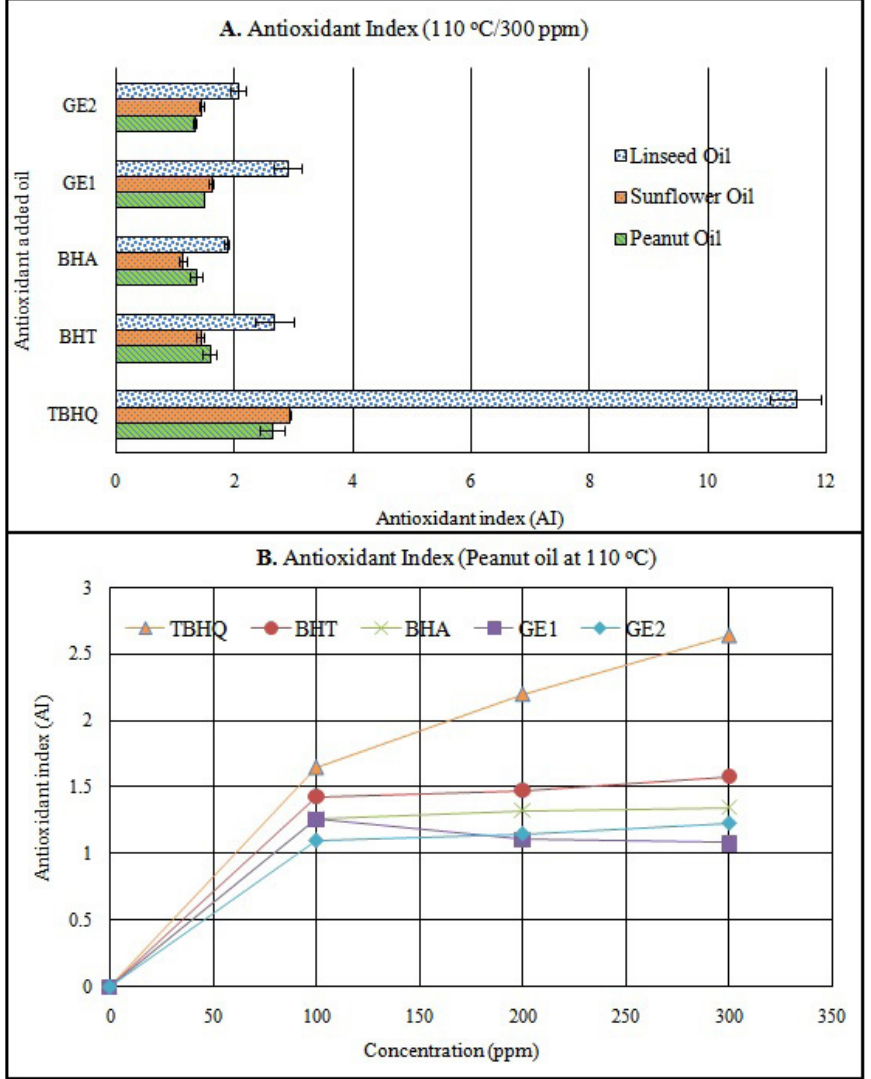
Figure 4: (A) Effect of changing oil on antioxidant index, (B) Effect of changing concentration of antioxidants on antioxidant